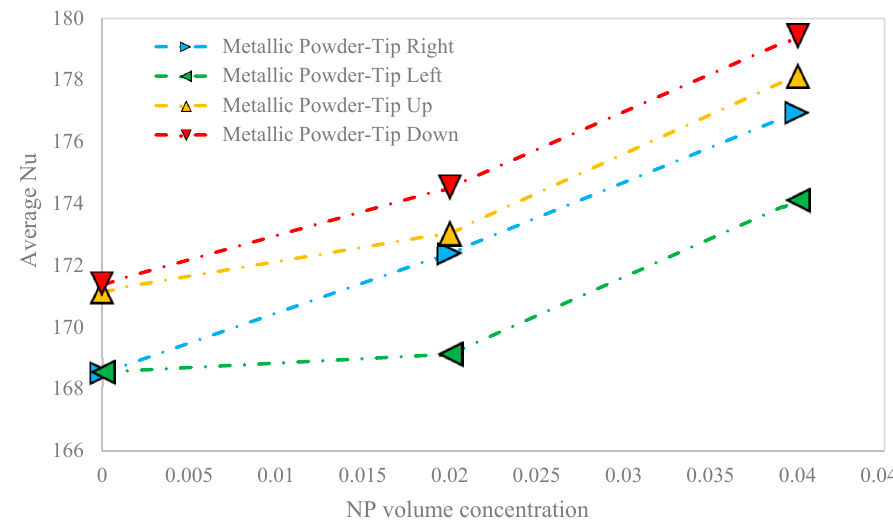
Figure 11. The variation of the average Nu versus the NP volume concentration for the metallic powder-based porous cavity and different orientations of the hot block .